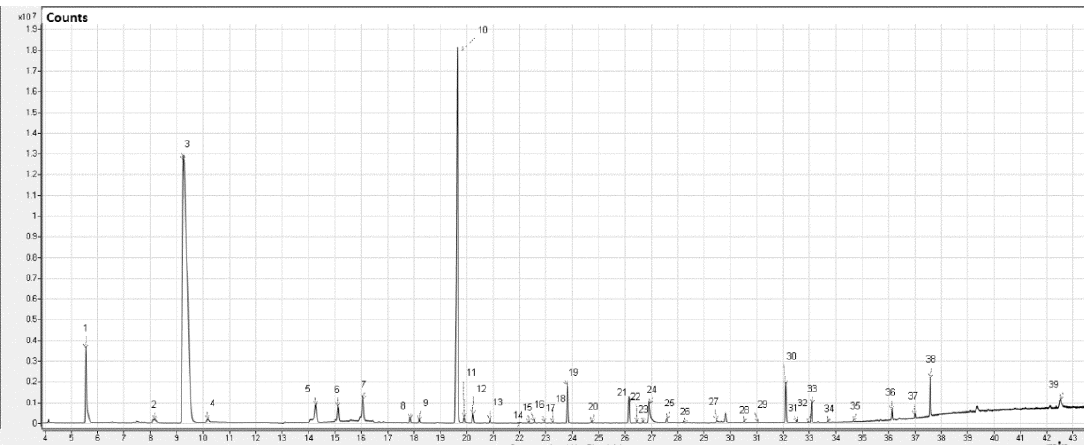
Figure 3. Typical GC-MS chromatogram of a Filuferru distillate by grape marc from Sardinia, Italy (sample 19, from Orotelli). Peak attribution: 1 : Acetaldehyde; 2 : Acetaldehyde, ethyl methyl acetal; 3 : Ethyl acetate and acetaldehyde, diethyl acetal (not resolved); 4 : 3-methyl-butanal; 5 : 1-propanol; 6 :